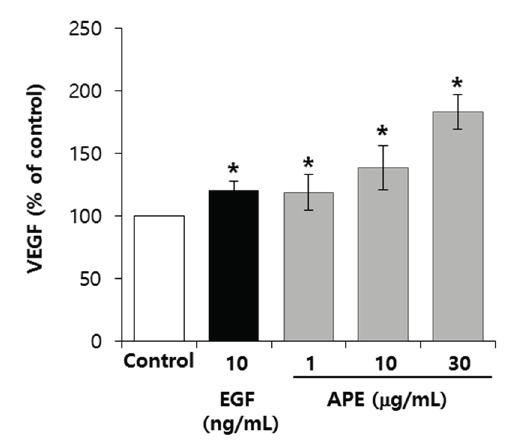
Figure 3. APE upregulates the VEGF secretion from the EpSCs. The EpSCs were cultured in a serum-free condition, with or without APE, for three days. Culture supernatants from the EpSCs were added to 96 well plates, coated with a polyclonal antibody of VEGF, and then sequentially proceeded using the streptavidin-biotin detection method. ( n = 3). The data are presented as the mean ± SD, * p <